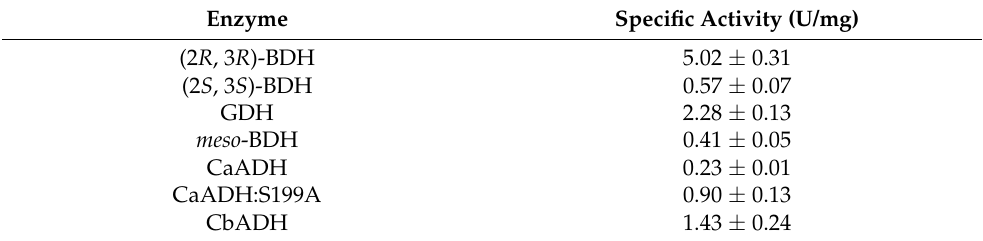
Table 1. Activity assays of seven candidate enzymes using 1,2-BD mixture a .